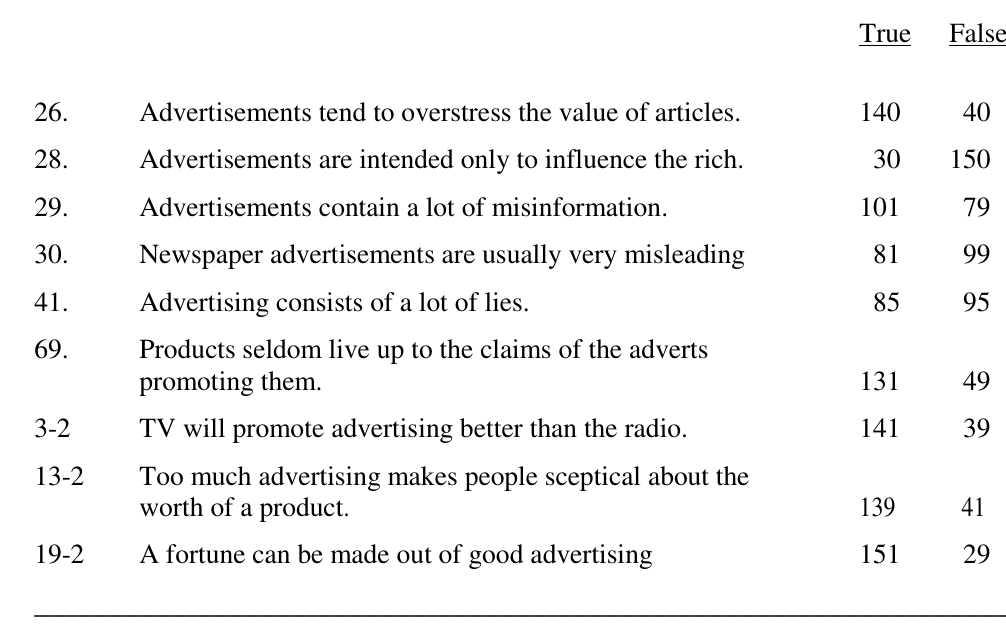
ITEMS REFLECTING ATTITUDES ON THE CREDIBILITY OF